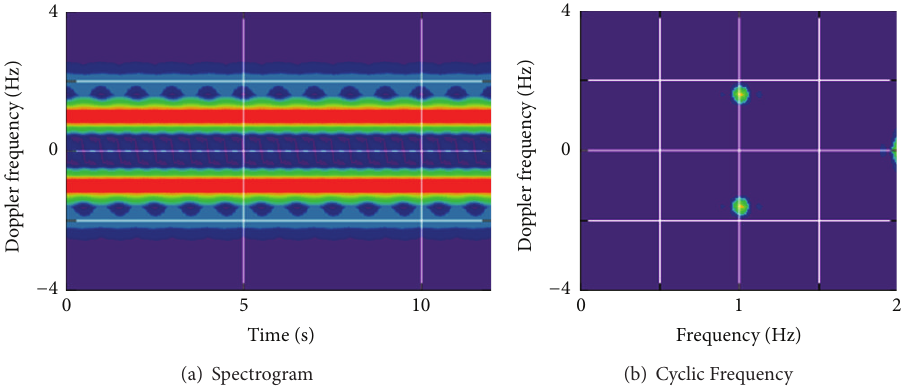
Figure 4: The simulation results with a displacement period of